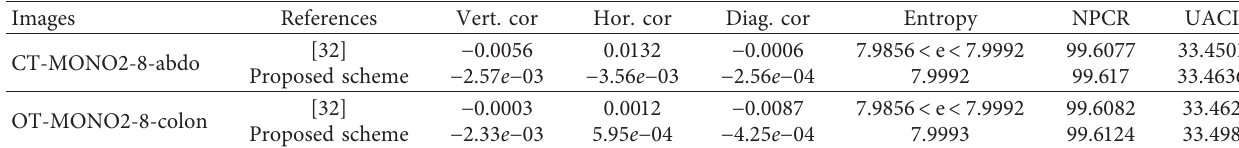
Table 13: Comparison of results on medical